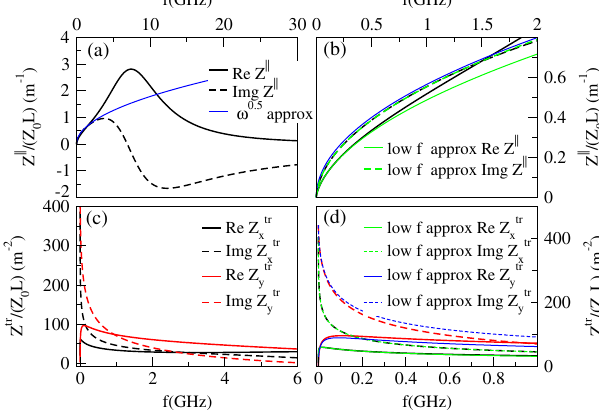
FIG. 2. Impedances of a parallel-plane pipe with (cid:8) ¼ (cid:8) iron (cid:3) 10 (cid:1) 4 with b ¼ 0 : 02 m . (a) and (b) Real (black continu- ous) and imaginary (black dashed) longitudinal impedance, Eq. (19). The low frequency approximation (blue) / Eq. (35) (blue) is not valid, while Eq. (40) (green) approximation hold up to 500 MHz. (c) and (d) Real and imaginary part of the horizontal (black continuous and black dashed) and the vertical (red continuous and red dashed) impedances, Eqs. (23) and (21). Equations (36) and (37) are not valid approximations, while Eq. (38) (green) and Eq. (39) (blue) are good only up to 200